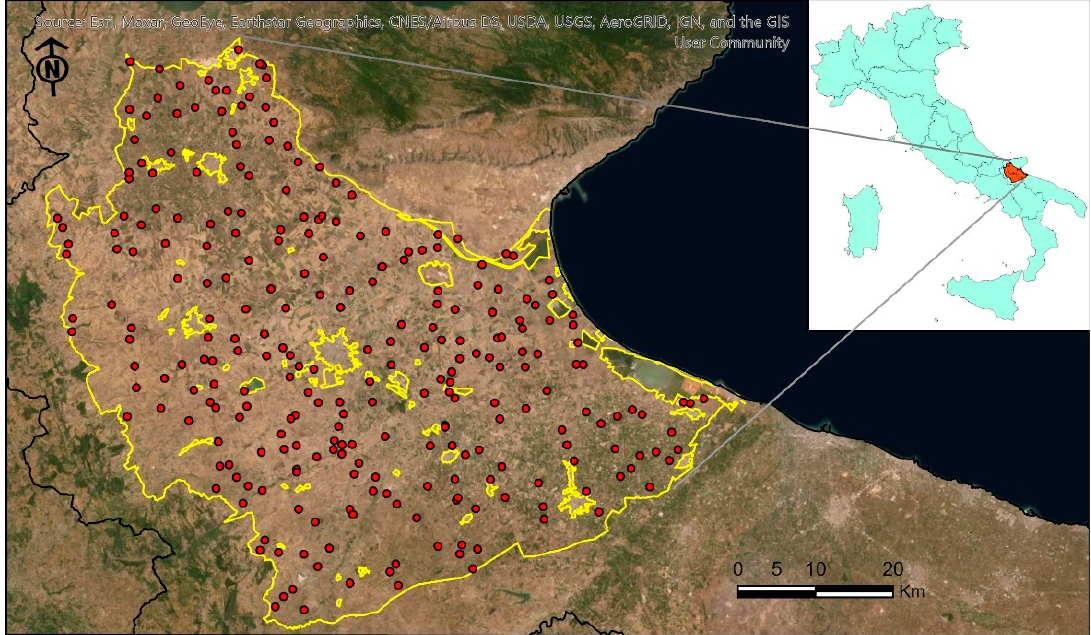
Figure 1. Location of the study area and distribution of the sample points. The red dots are the georeferenced sample points, and the yellow area represents the limit of the study area.